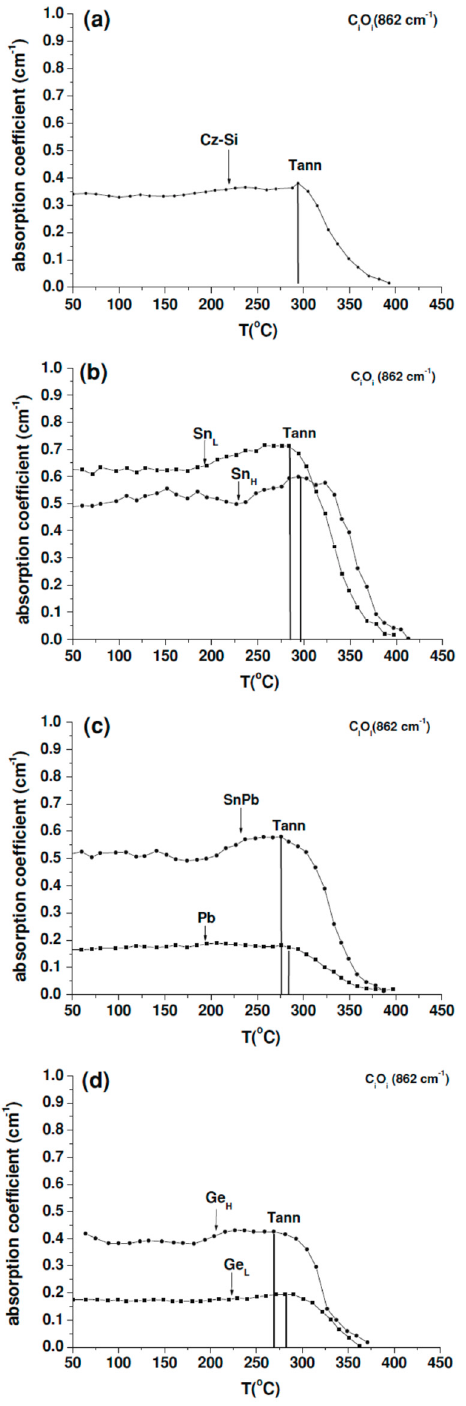
Figure 20. Evolution with temperature of the C i O i defect for various isovalent dopants. For ( a ) Cz-Si, ( b ) Sn L and Sn H , ( c ) SnPb and Pb, and ( d ) Ge L and Ge H Si samples. Reproduced with permission from [158].